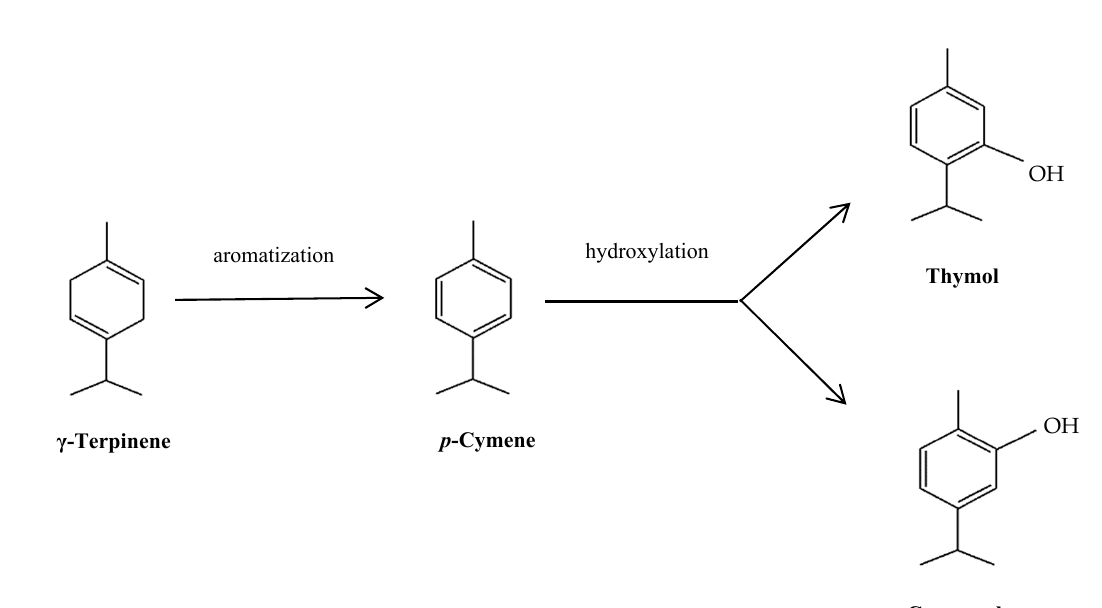
Figure 9. Biosynthetic pathway of thymol and carvacrol from γ -terpinene and p -cymene (adapted from Nhu-Trang [49].